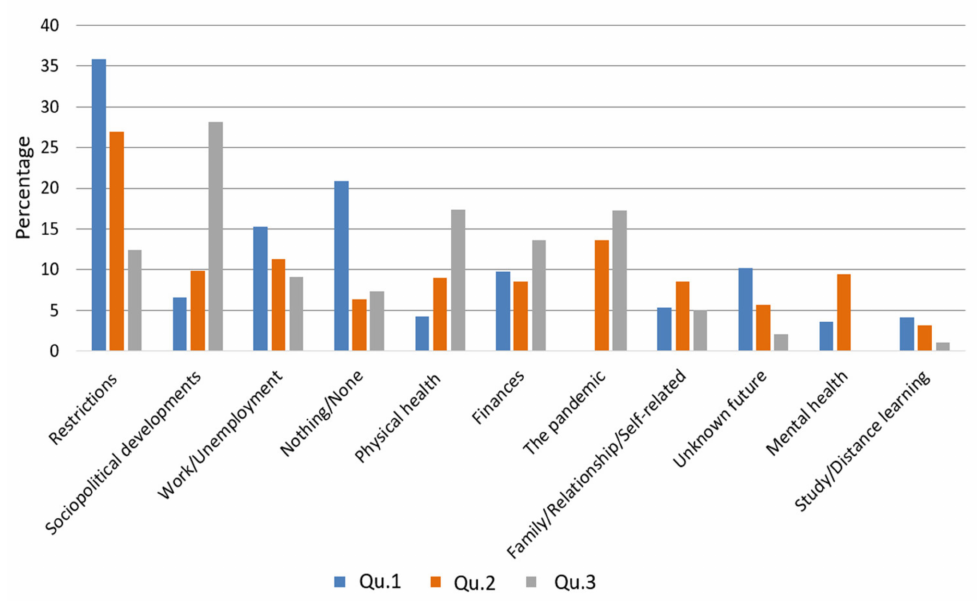
Figure 4. Percentages of main categories for questions 1–3. The percentages of participants for each question (1–3) reporting each main category of response, ordered by total. Qu.1 refers to “problem areas since beginning of pandemic”; Qu.2 to “greatest current concern”; Qu.3 to “greatest future concern”.